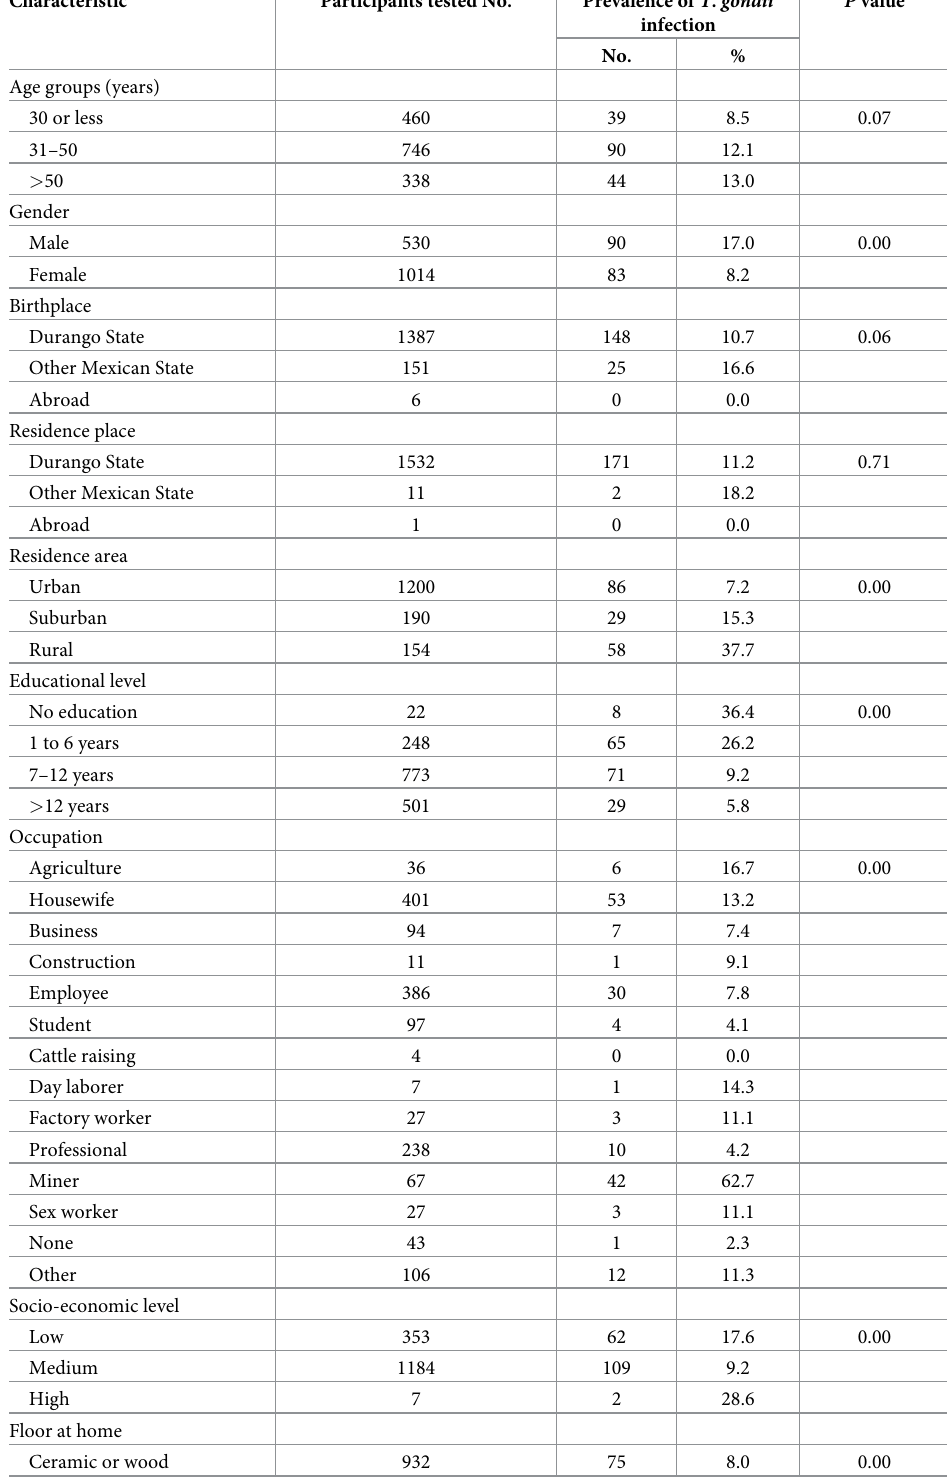
Table 1. Socio-demographic and housing characteristics of participants and seroprevalence of T . gondii infection.